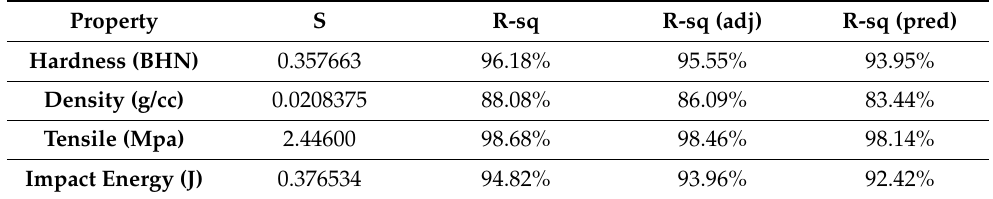
Table 3. Model summary for